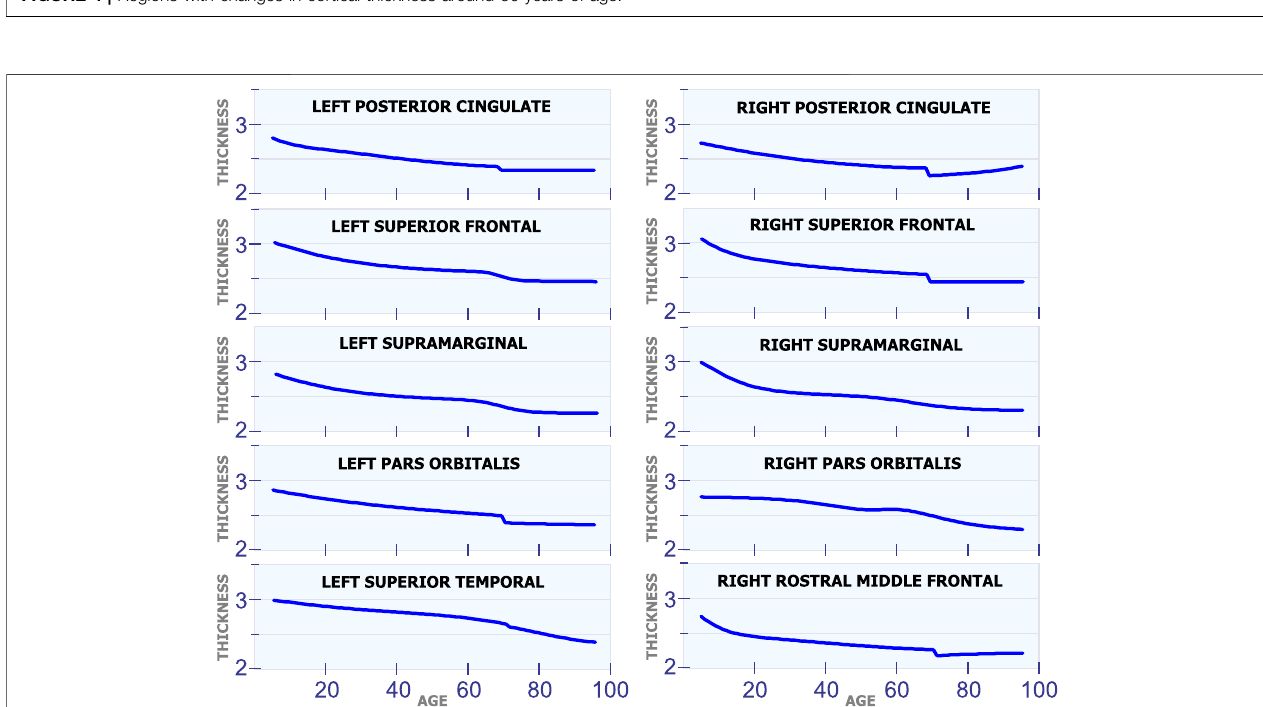
FIGURE 5 | Regions with changes in cortical thickness around 70 years of